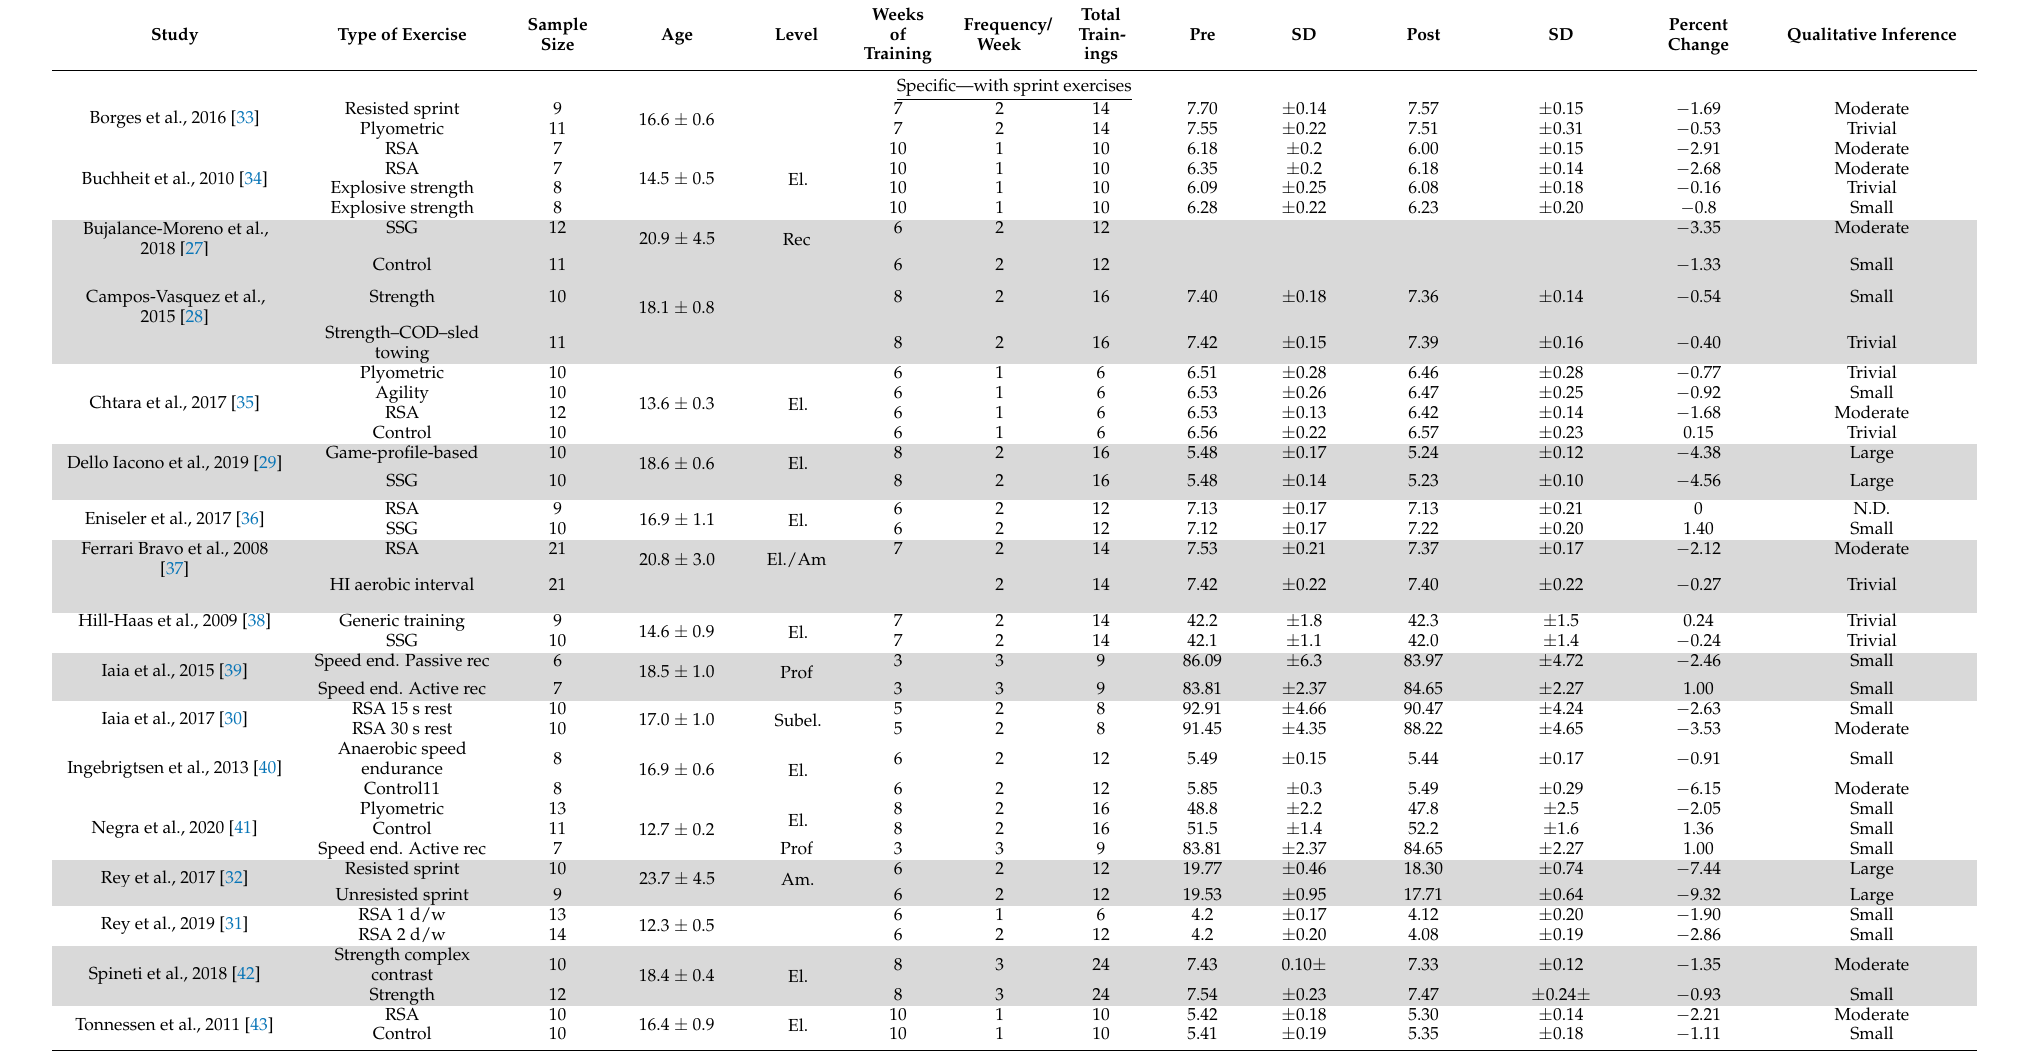
Table 1. Characteristics and results of the studies in accordance with intervention program and